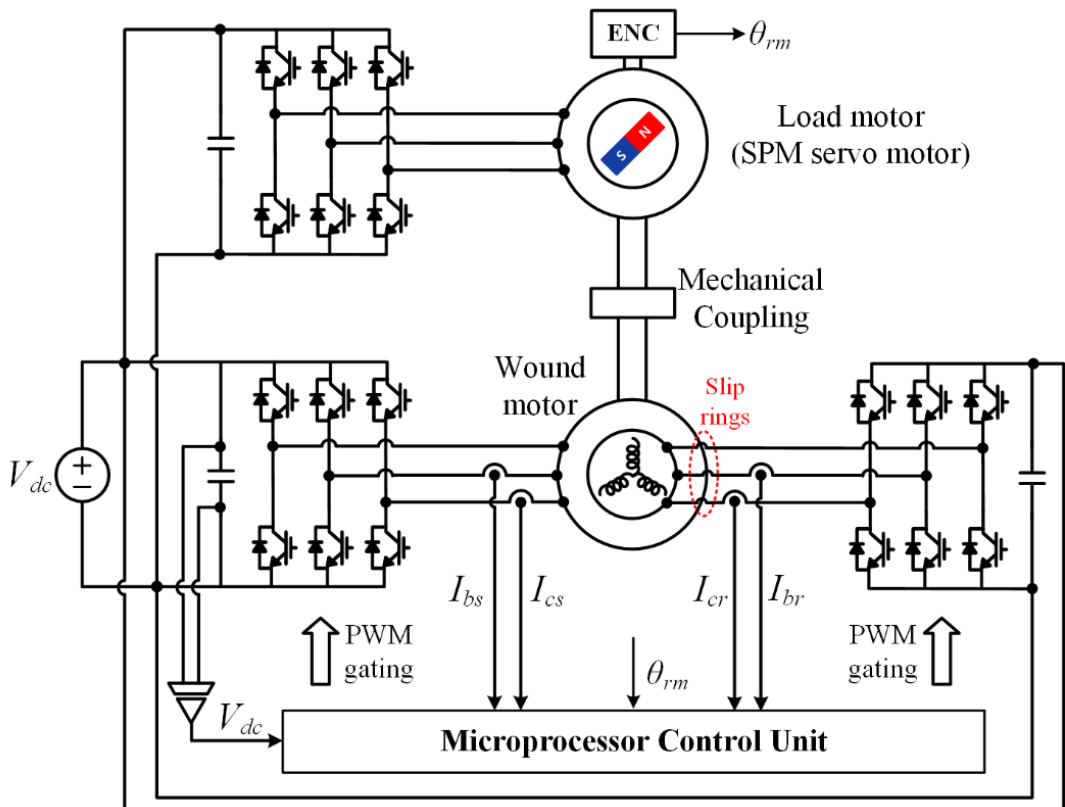
Figure 8. Block diagram of experimental set-up.